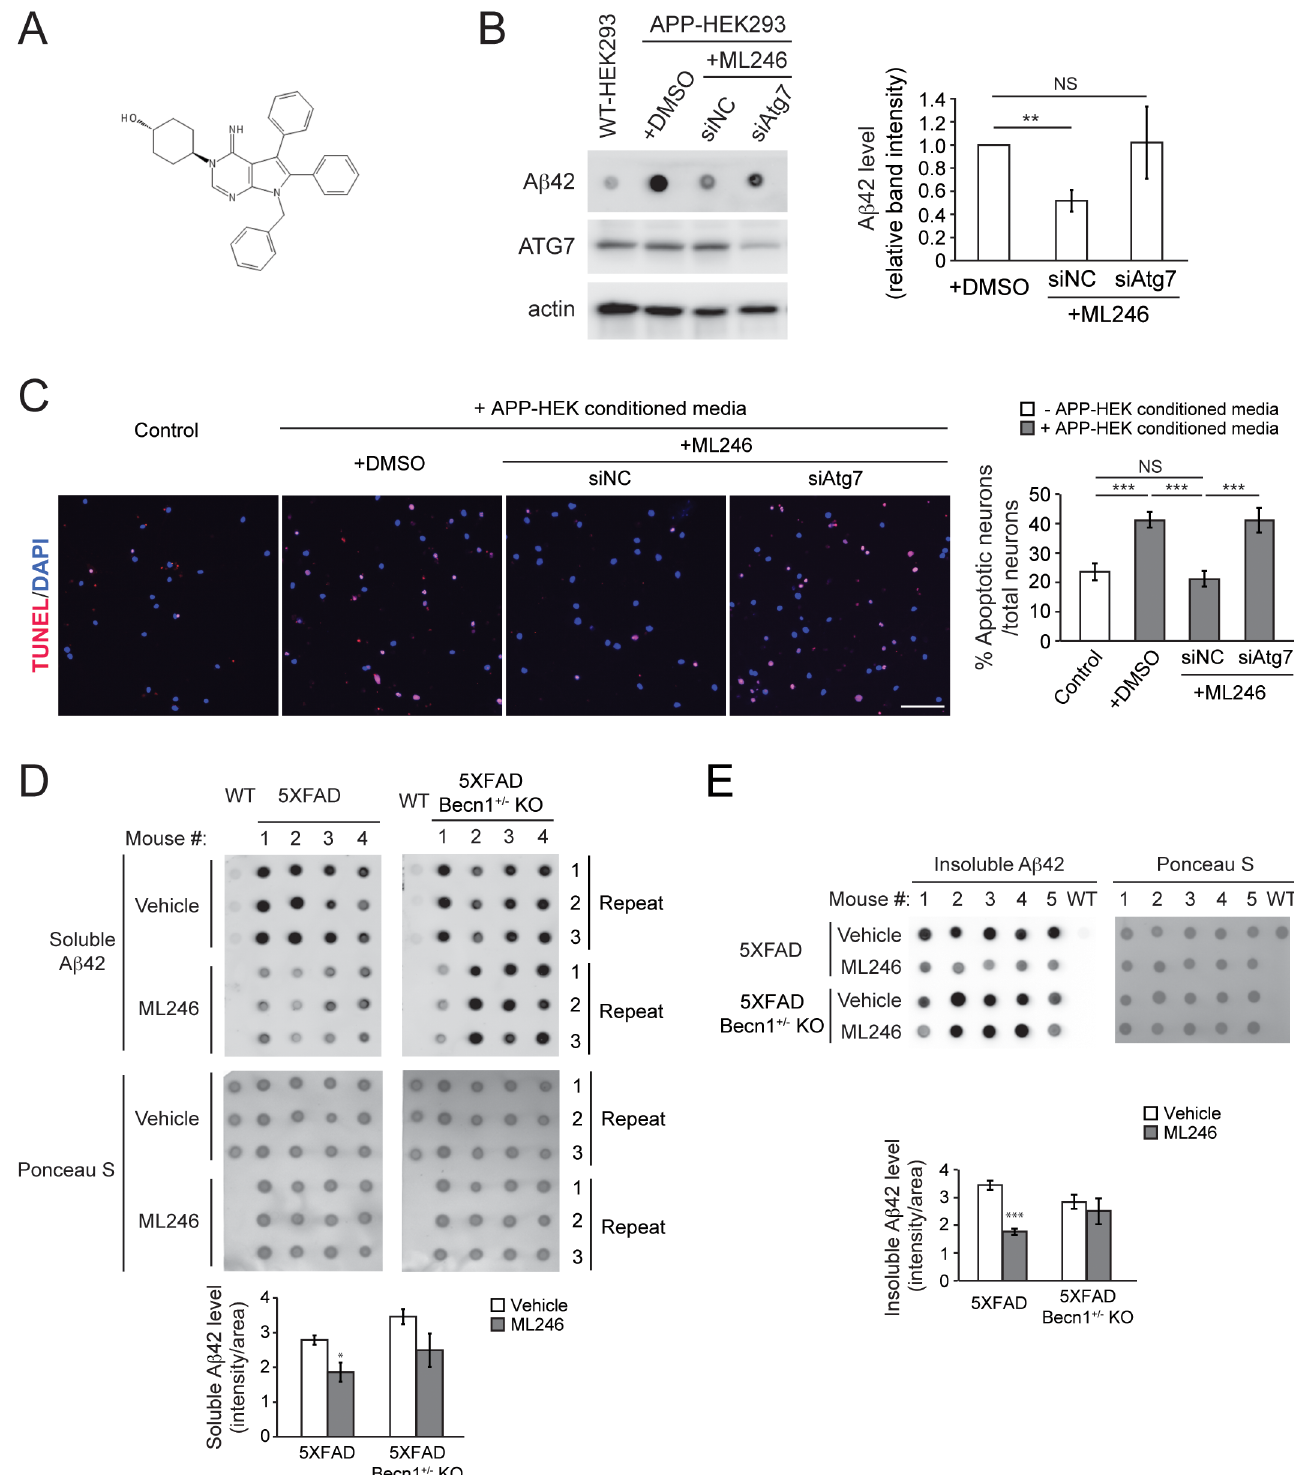
Fig 6. An autophagy-inducing compound ML246 reduces amyloid load in an autophagy-dependent manner in vitro and in vivo. (A) Chemicalstructure of ML246. (B) Dot-blot assays (left) and quantification (right) of secreted A β 42 levels in conditioned media of HEK293 cells stably expressingAPP treated with vehicle(DMSO) or ML246for 24 h, immunostained with anti-A β 42 antibody. Cells were transfected with non-targeting control (NC) or ATG7 siRNA 24 h prior to ML246treatment. Results are quantifiedfrom 4 independentexperiments. (C) Representative images (left) and quantification (right) of TUNEL signals (red) in WT primary cortical neuronstreated with conditioned media from ( B ) for 24 h. Nuclei were stained